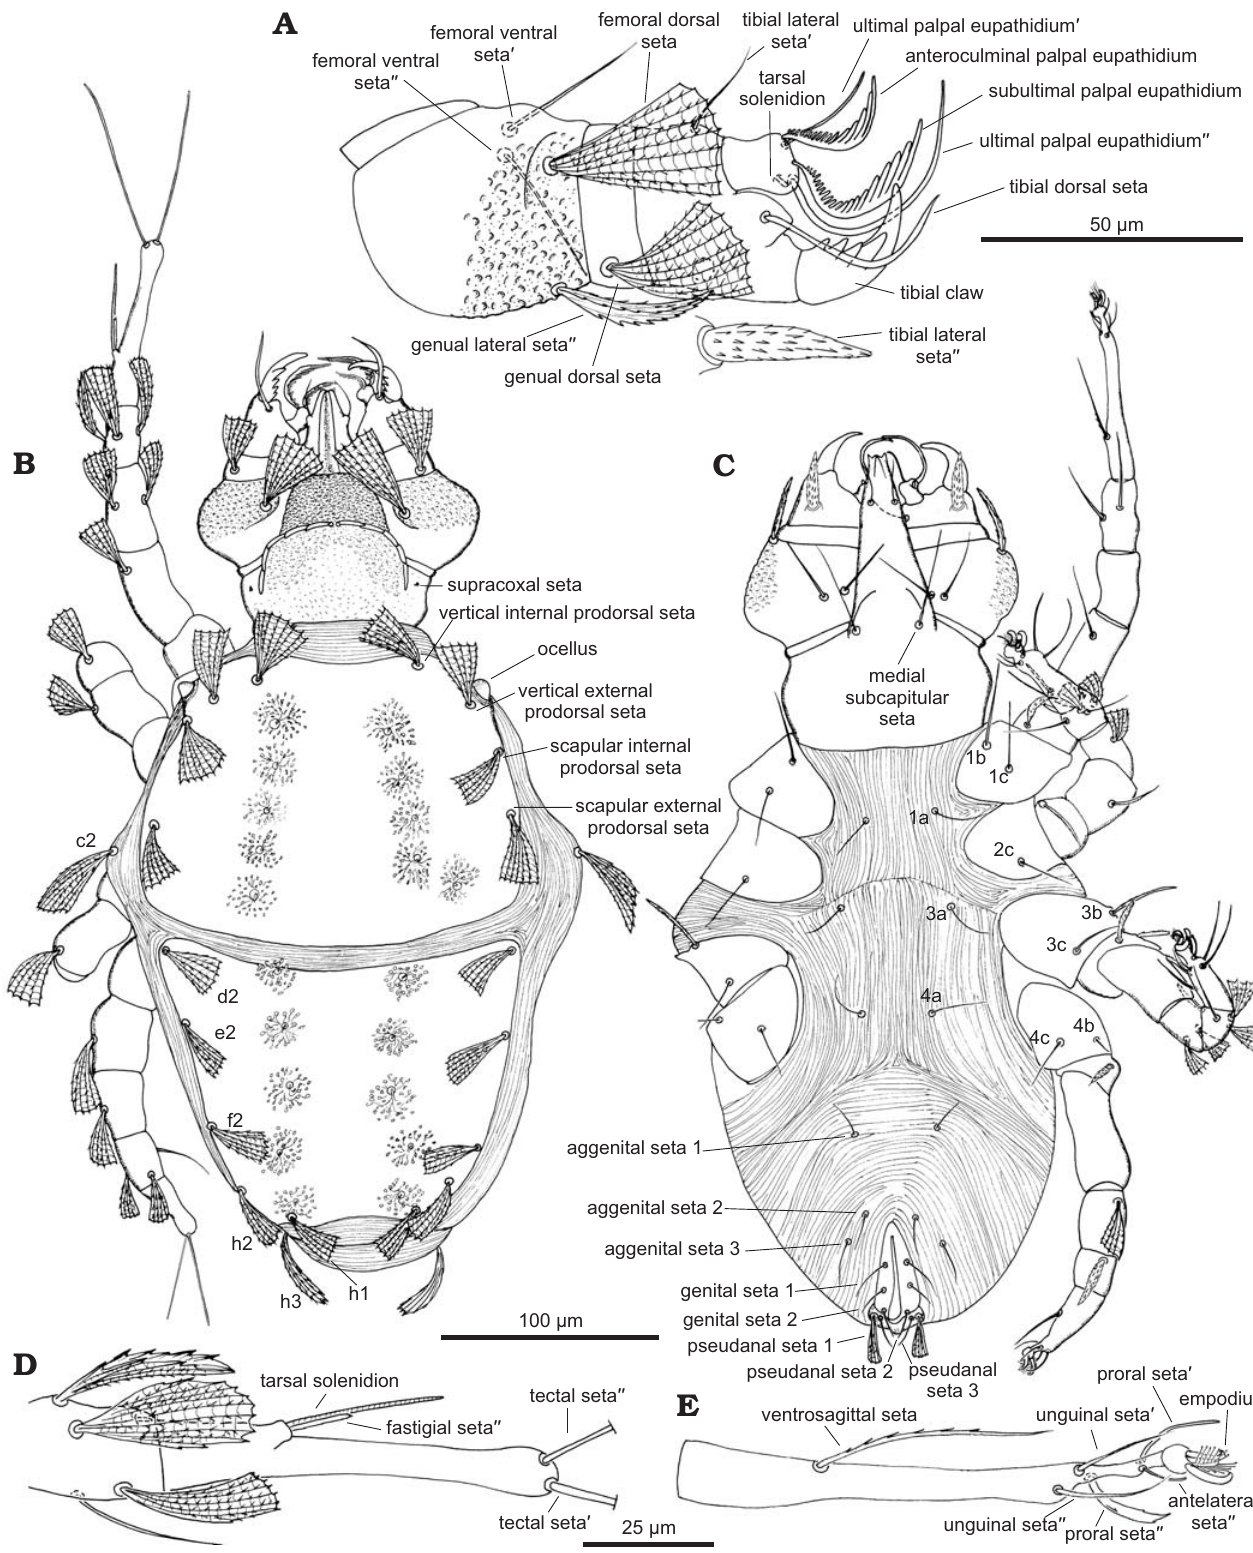
Fig. 1. Cheyletid mite Cheletomimus crinitus sp. nov., female holotype (SMF Be 2537, ex. CCHH 448-1) from Baltic amber (Baltic Sea coast, most likely Sambian Peninsula, middle to upper Eocene, 37–54.5 Mya), reconstruction (leg positions altered for clarity). Dorsal ( B ) and ventral ( C ) views, right palp ( A ) and left tibia and tarsus I ( D ) in dorsal views, left tarsus I in ventral view ( E ). Abbreviations: 1a–c, 2c, 3a–c, 4a–c, coxal setae of coxae 1–4, respec- tively; c2, d2, e2, f2, h1–h3, dorsal setae, associated with body segments C, D, E, F, H, respectively; ′ and ′′ refer to position of seta in pseudosymmetrical pair on appendage: anterior or posterior,